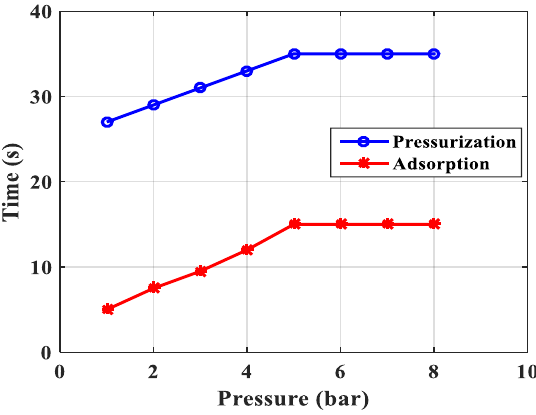
Figure 17. Adsorption time depends on adsorption pressure.